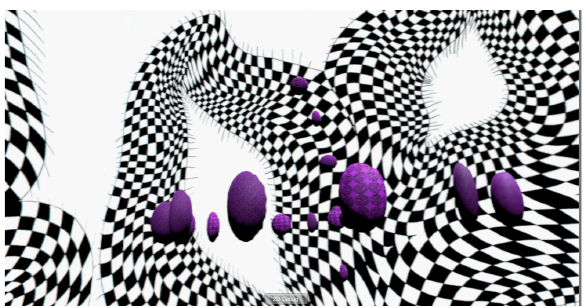
Figure 3. AudioVirtualizer scene 1a Detected percussive onsets swap the visible texture on